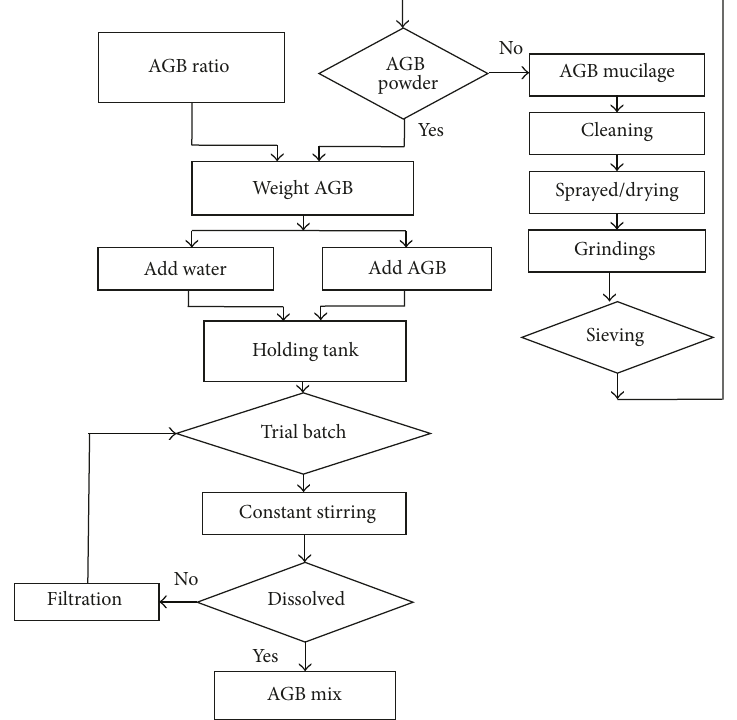
Figure 2: Mixing process of